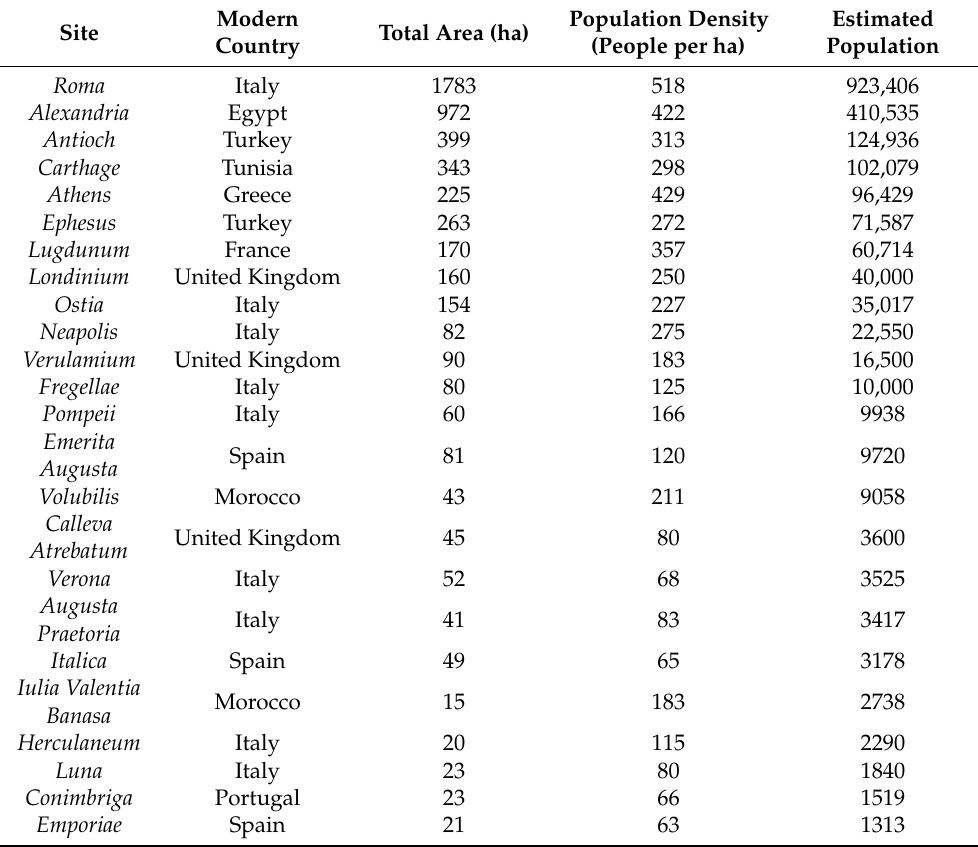
Table 1. Total area, population density and estimated population of Pompeii and Herculaneum com- pared with other major ancient cities of the Roman